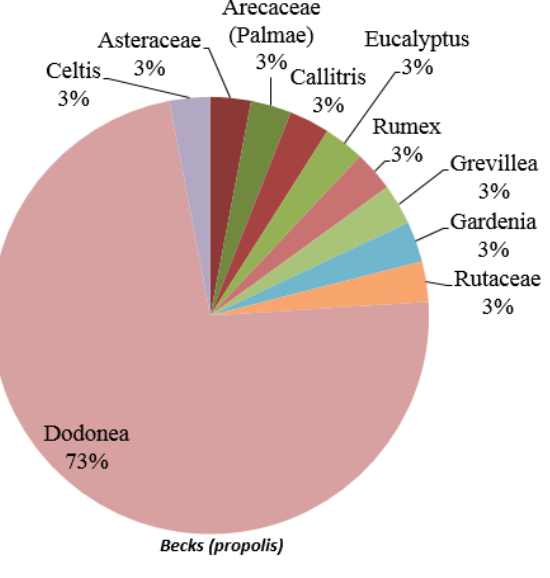
F IGURE 8. Pollen types in propolis samples from Tetragonula carbonaria native stingless beehives (Becks